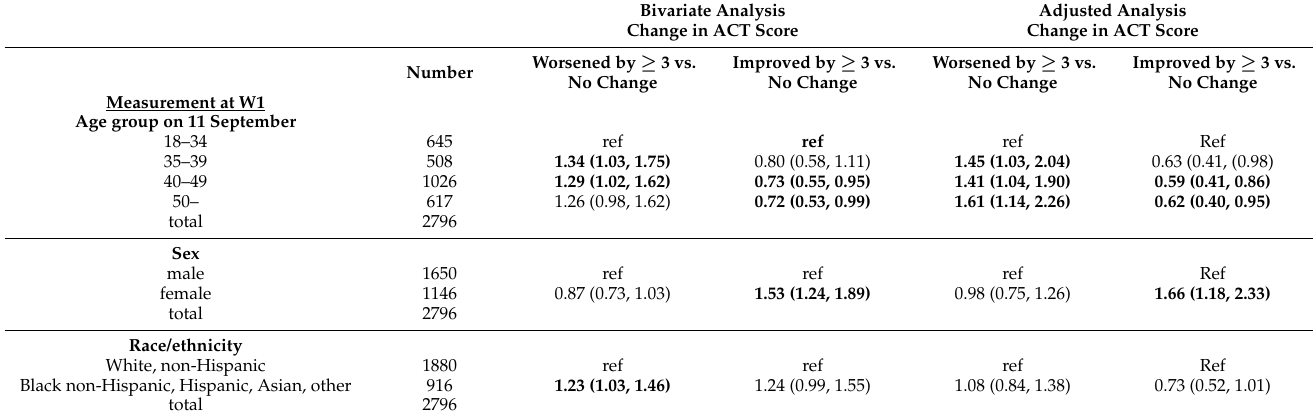
Table 4. Bivariate and adjusted multivariable multinomial logistic regression for clinically significant change in ACT score versus demographics and clinically significant change in physical, and mental health factors from W3 to W4, odds ratios and 95% confidence